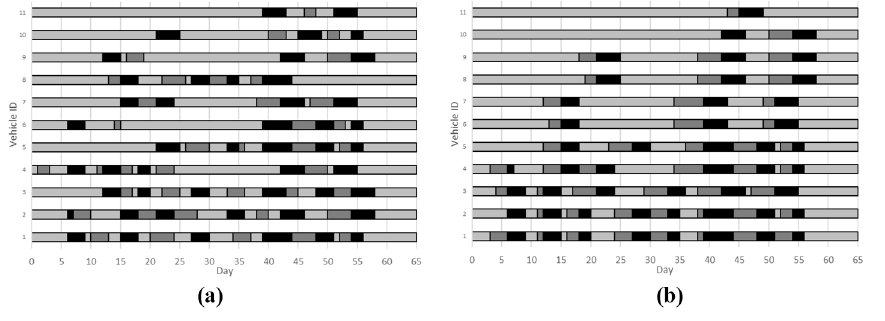
Figure 1. Optimal (a) and